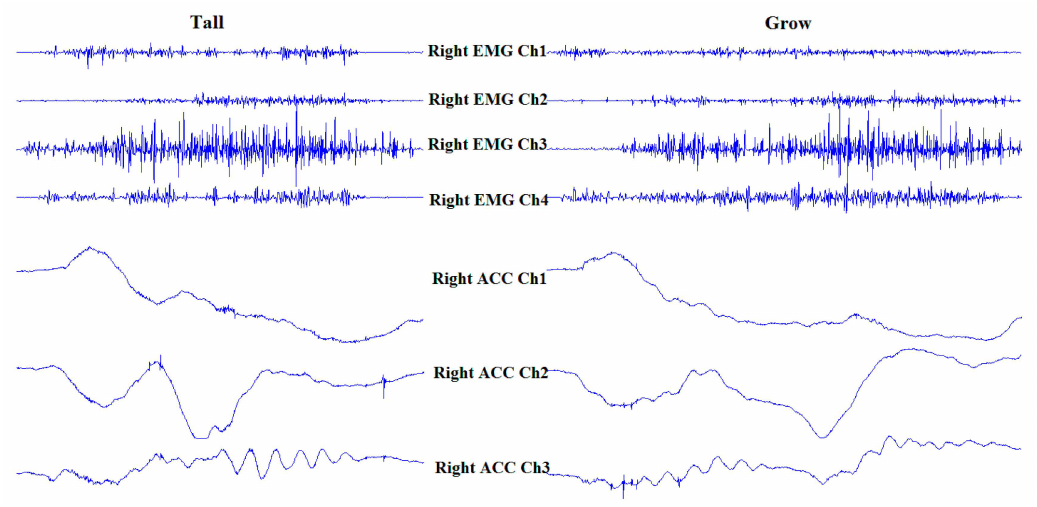
Figure 6. SEMG and ACC signals of subwords “tall” and